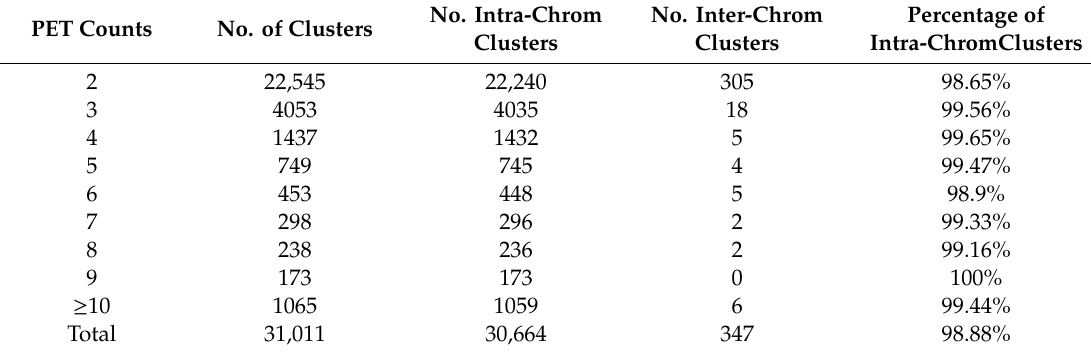
Table 2. Statistics of interactions with Paired-End Tag (PET) counts.